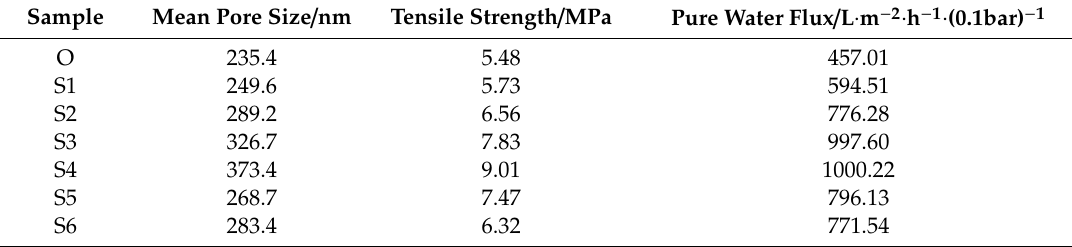
Table 2. The mean pore size, tensile strength, and pure water flux (PWF) of the PVDF hollow fiber membrane samples.